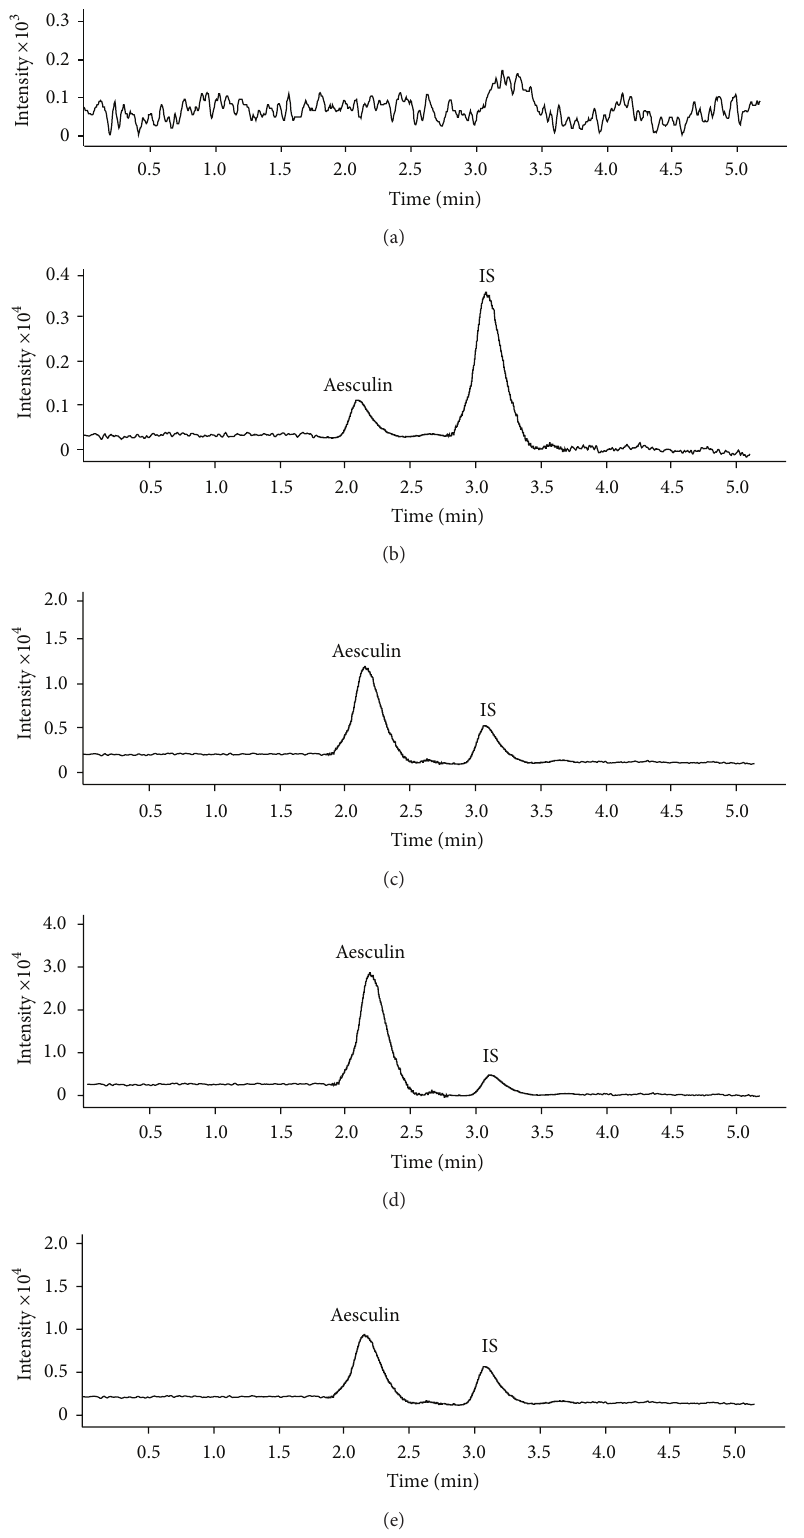
Figure 1: Representative extracted chromatograms for (a) blank plasma, (b) blank plasma containing 40.0 ng/mL aesculin and 10.0ng/mL IS, (c) blank plasma containing 500.0 ng/mL aesculin and 10.0ng/mL IS, (d) blank plasma containing 1200.0 ng/mL aesculin and 10.0ng/mL IS, and (e) plasma sample collected at 0.17 after single oral dose of Cortex fraxini extract (5.0